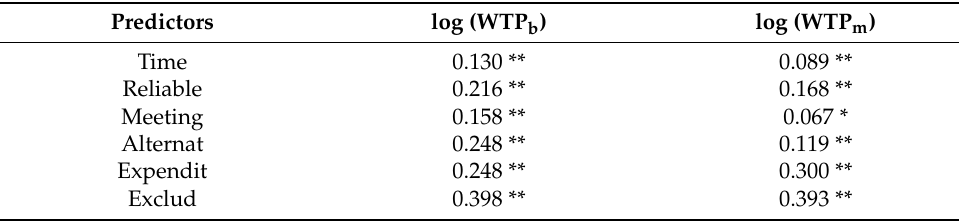
Table 7. Correlation indexes for log (WTPb), log (WTPm) and predictors.